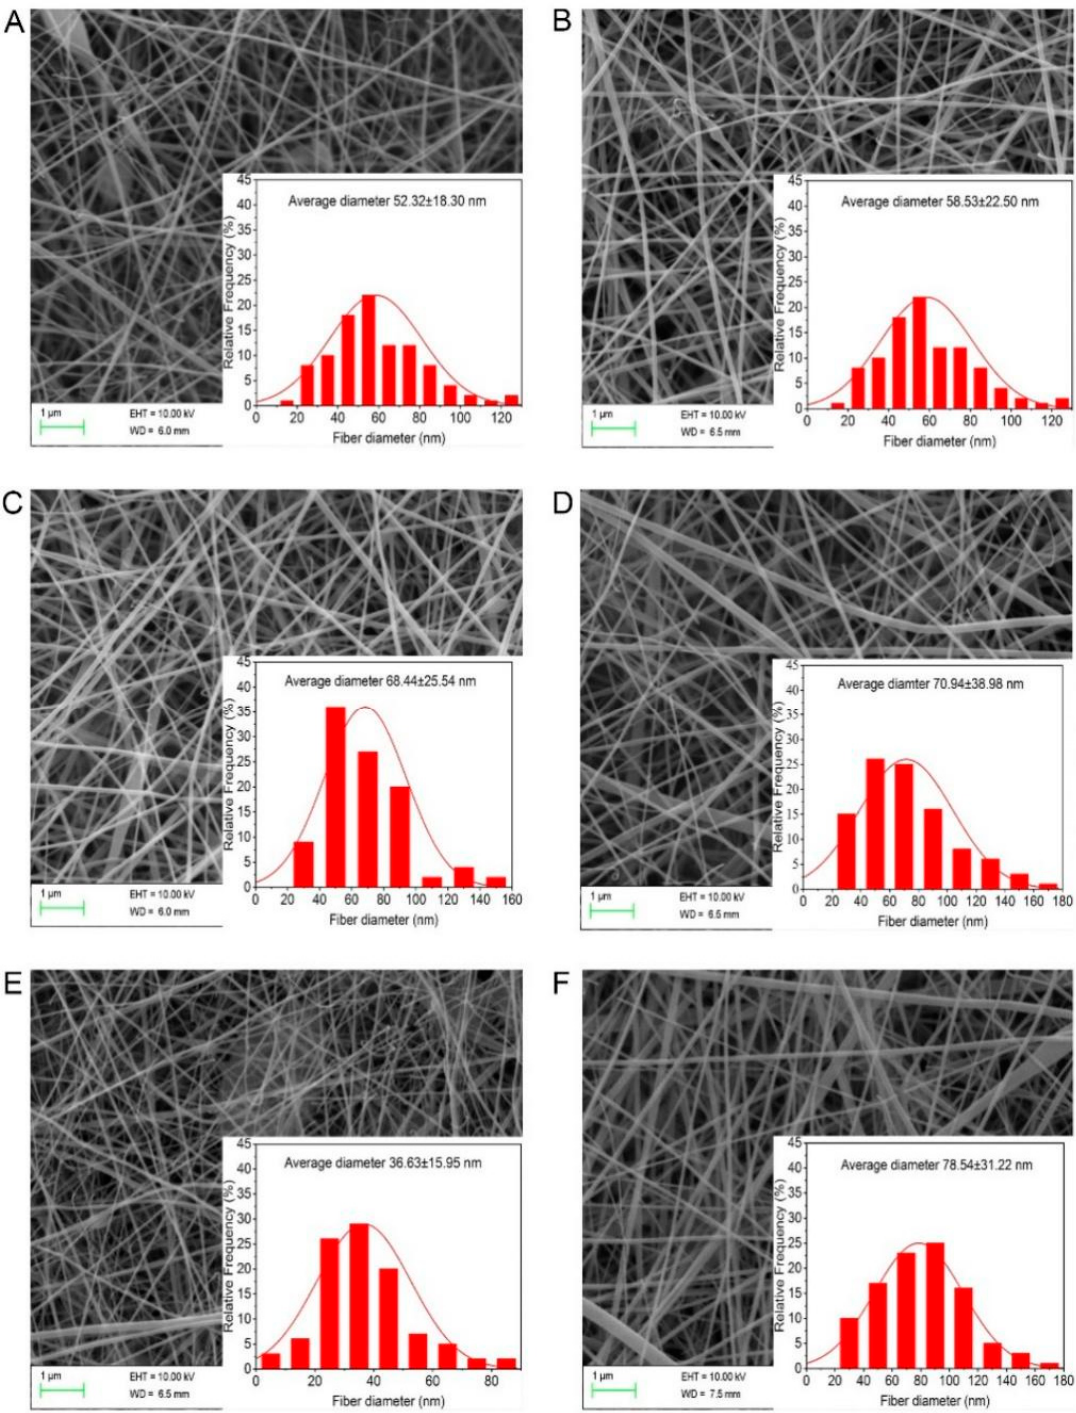
Figure 2. SEM images and diameter distributions of the gelatin/zein/perillaldehyde nanofiber films. ( A ) G/Z/P (5:1:0.0025), ( B ) G/Z/P (5:1:0.005), ( C ) G/Z/P (5:1:0.01), ( D ) G/Z/P (5:1:0.02), ( E ) G/Z/P (5:1:0.04), ( F ) G/Z.